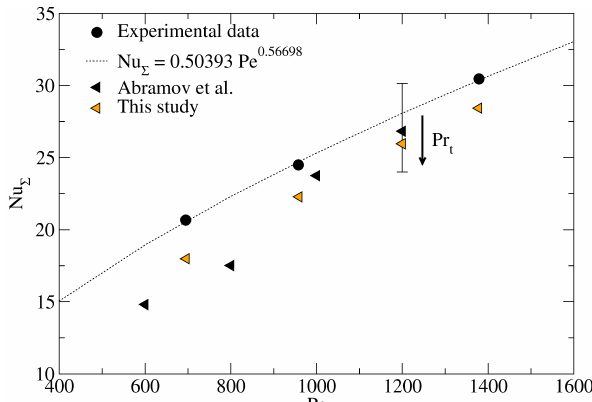
Figure 4. Arithmetic average Nu Σ plotted against Pe for URANS simulations (only compact bank). Dashed line marks regression of experimental data presented in [14]. Bar at Pe = 1.2 × 10 3 is showing the result spread for Pr t =